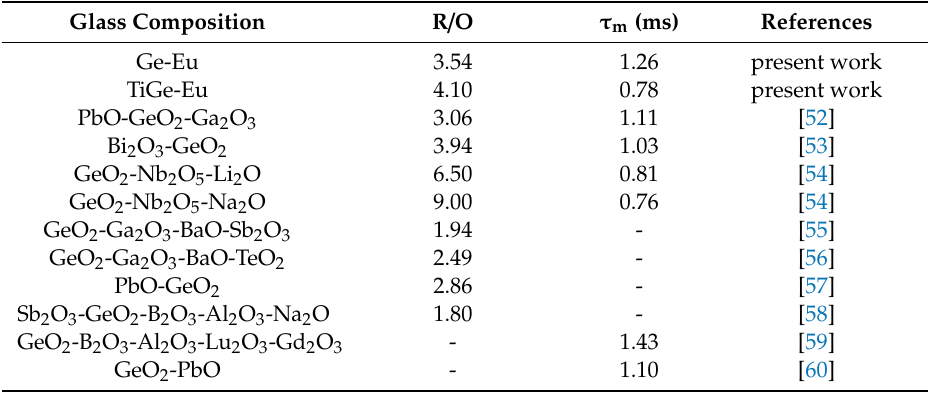
Table 3. Comparison of spectroscopic parameters of Eu 3 + -doped germanate glasses. Glass